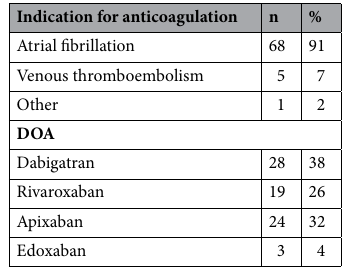
Table 1. Indication for antiocoagulant therapy and distribution of differente DOAC among